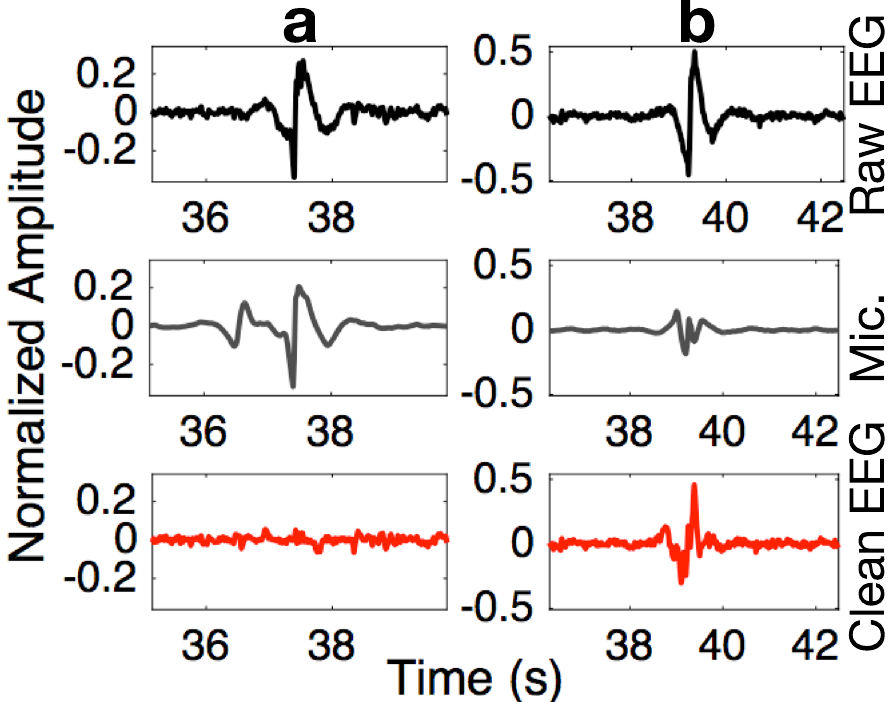
Figure 5. Denoising of ear-EEG from mechanical jaw clench artifacts. ( a ) Best-case denoising scenario for which the artifact measurement with the embedded microphone was accurate. ( b ) Worst-case accuracy of artifact measurement with the embedded microphone, note that the artifact was nevertheless reduced in the Clean EEG trace. (Top panels) Raw EEG corrupted by a strong artifact. (Middle panels) Output of the mechanical sensor within the MMS. (Bottom panels) Denoised EEG using the mechanical MMS signal as